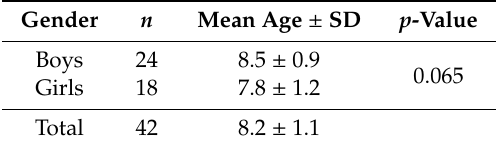
Table 1. Distribution of gender and age of children in this study.